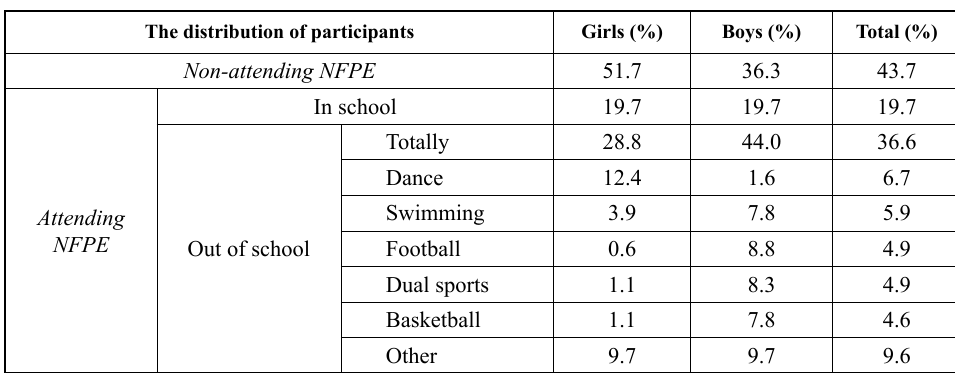
Table 1. Distribution of sixth grade pupils’ participation and non-participation in